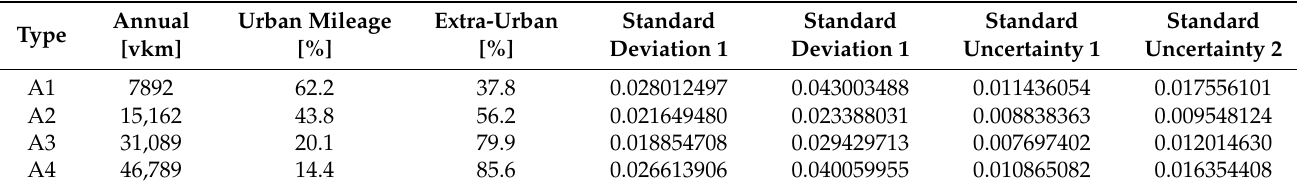
Table 3. Input data for the main model, taking into account the types of users and vehicle-kilometers as well as the correlation of driving